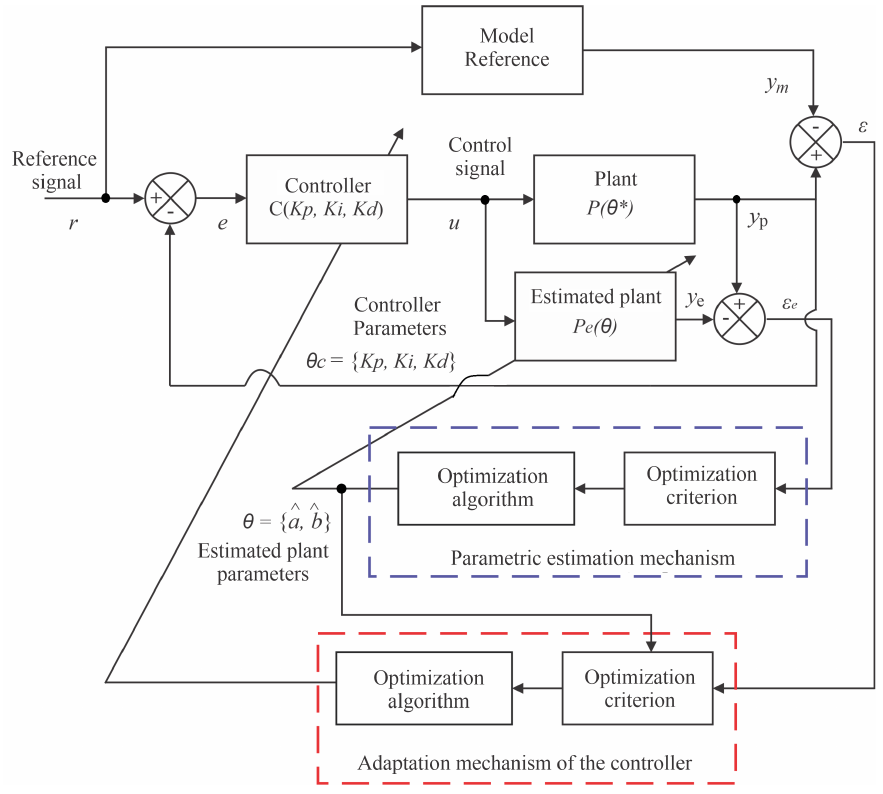
Figure 4. IMRAC-PID block